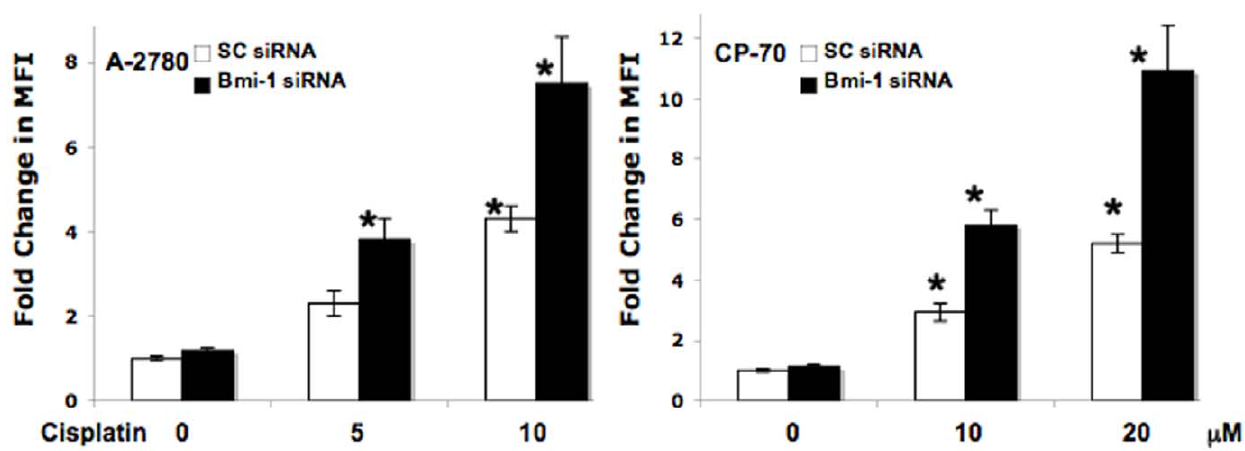
Figure 2. Bmi-1 knockdown increases cisplatin-mediated ROS production in ovarian cancer cells. Ovarian cancer cells transfected with scrambled control or Bmi-1 siRNA were treated with or without cisplatin for 24 h. Subsequently the cells were incubated with 5 m M carboxy- H2DCFDA in fresh HBSS for 30 min at 37 u C. The cells were harvested with trypsin and fluorescence of the labeled cells was measured at an excitation wavelength of 485 nm and emission wavelength of 530 nm by using Fluorolog 3 (Jobin-Yvon Horiba). Ratio of mean fluorescence intensity (MFI) with respect to the untreated scrambled control is represented.